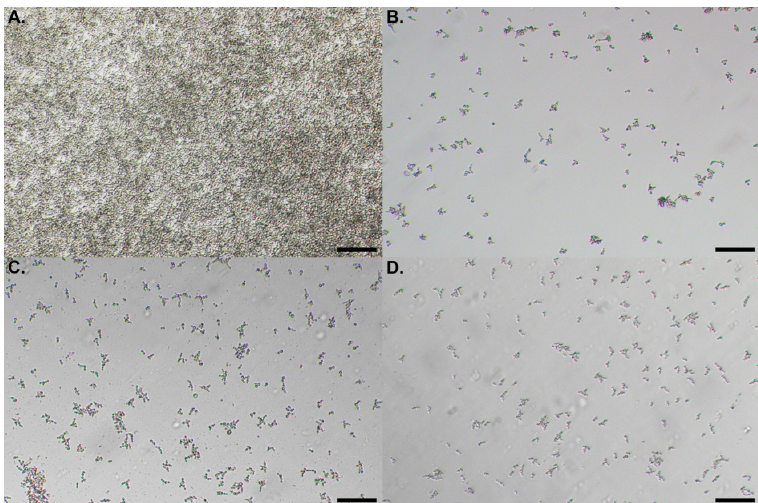
Figure 3. Microscopic observations of 24 h C. albicans biofilm non-treated ( A ) or treated with 2 mg/mL of hexane extracts from 1-year-old stems ( B ), 3-month-old stems ( C ) and leaves ( D ) of R. idaeus (10× objective, scale-bar represents 20 µm).